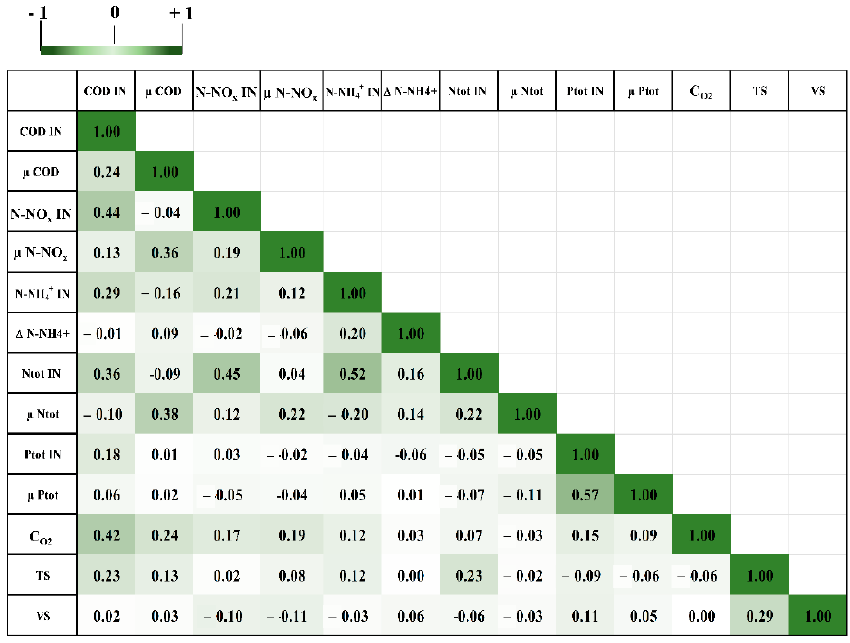
Figure 2. Pearson’s correlation matrix.